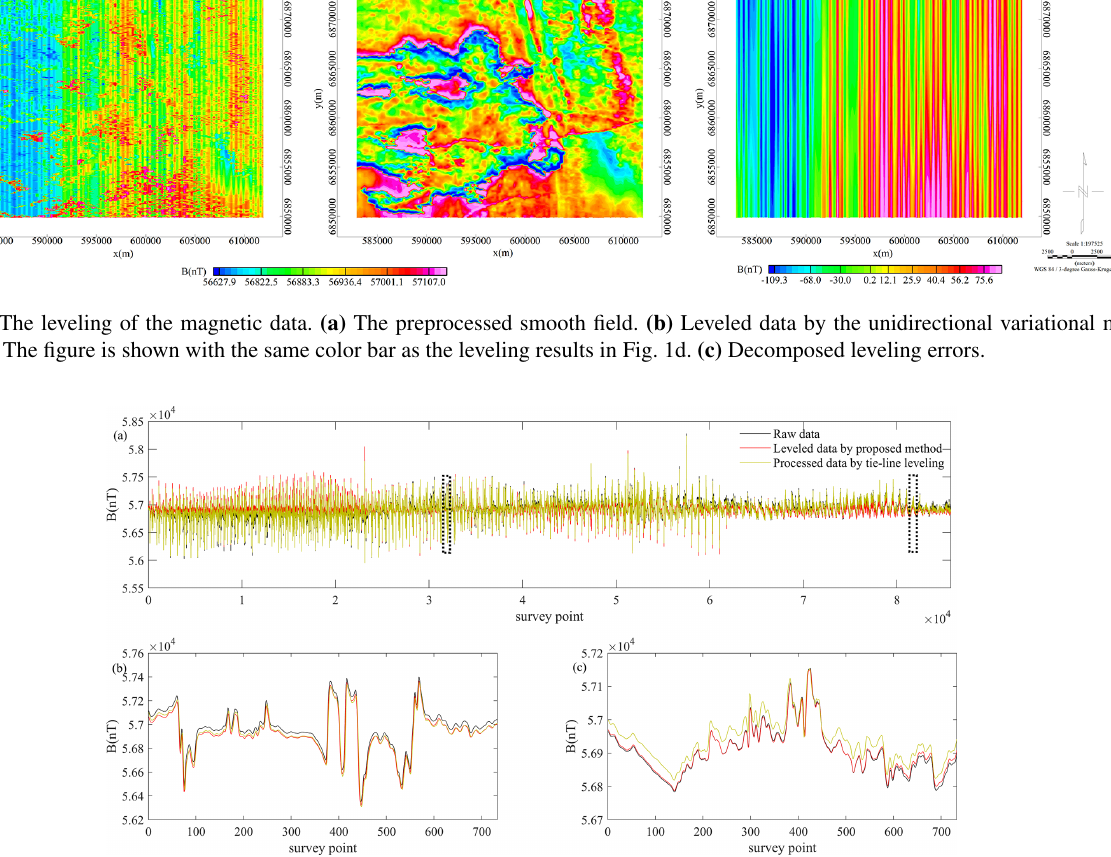
Figure 6. Leveled magnetic data. (a) All flight line data. (b) The 44th flight line data, corresponding to the first black dotted rectangle in (a) . (c) The 112nd flight line data, corresponding to the second black dotted rectangle in (a)